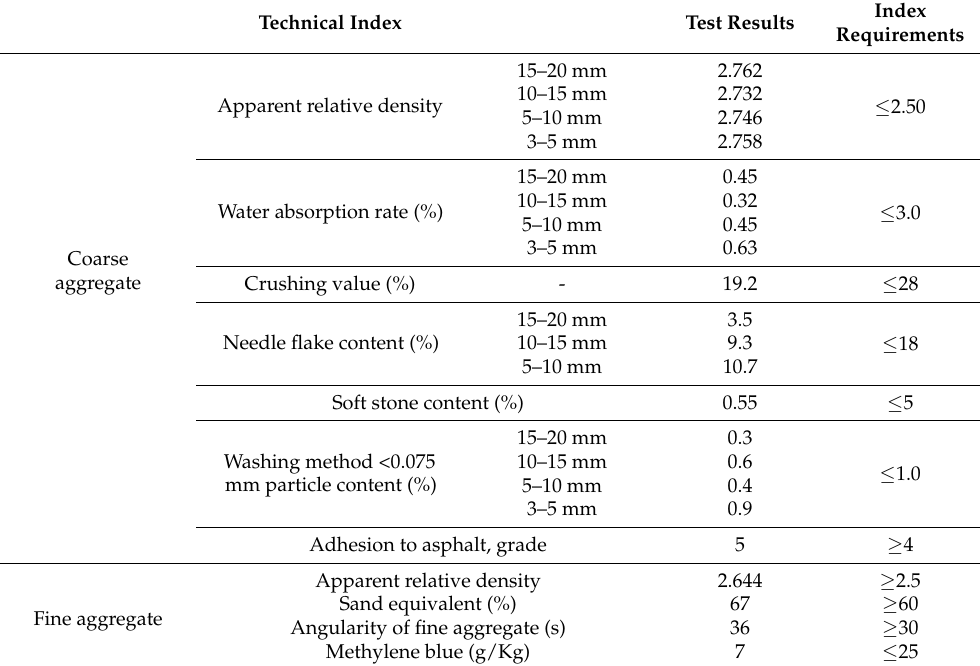
Table 1. Properties of coarse and fine aggregate.